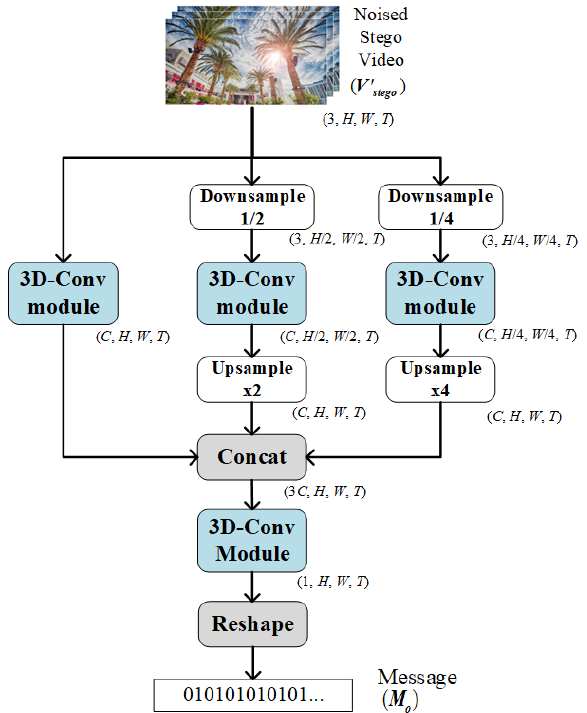
Figure 3. The network design of decoder.